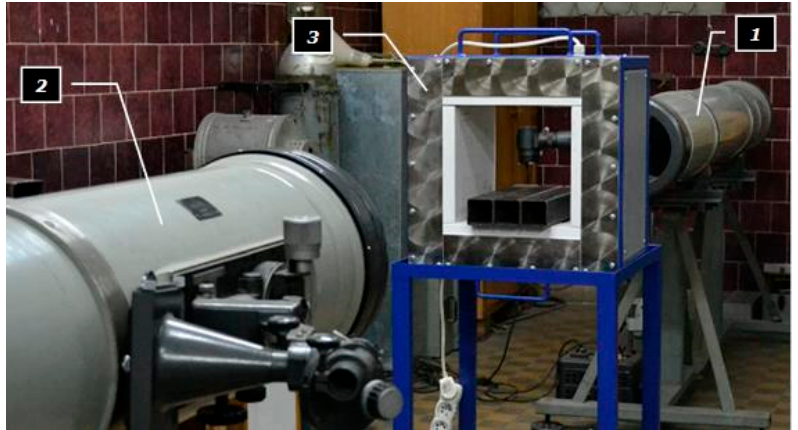
Figure 10. A stand for visualisation of convection phenomena using the Schlieren method: (1) part of the apparatus that generates the light beam; (2) part that displays the disturbed light beam, (3) electric furnace with the sample.